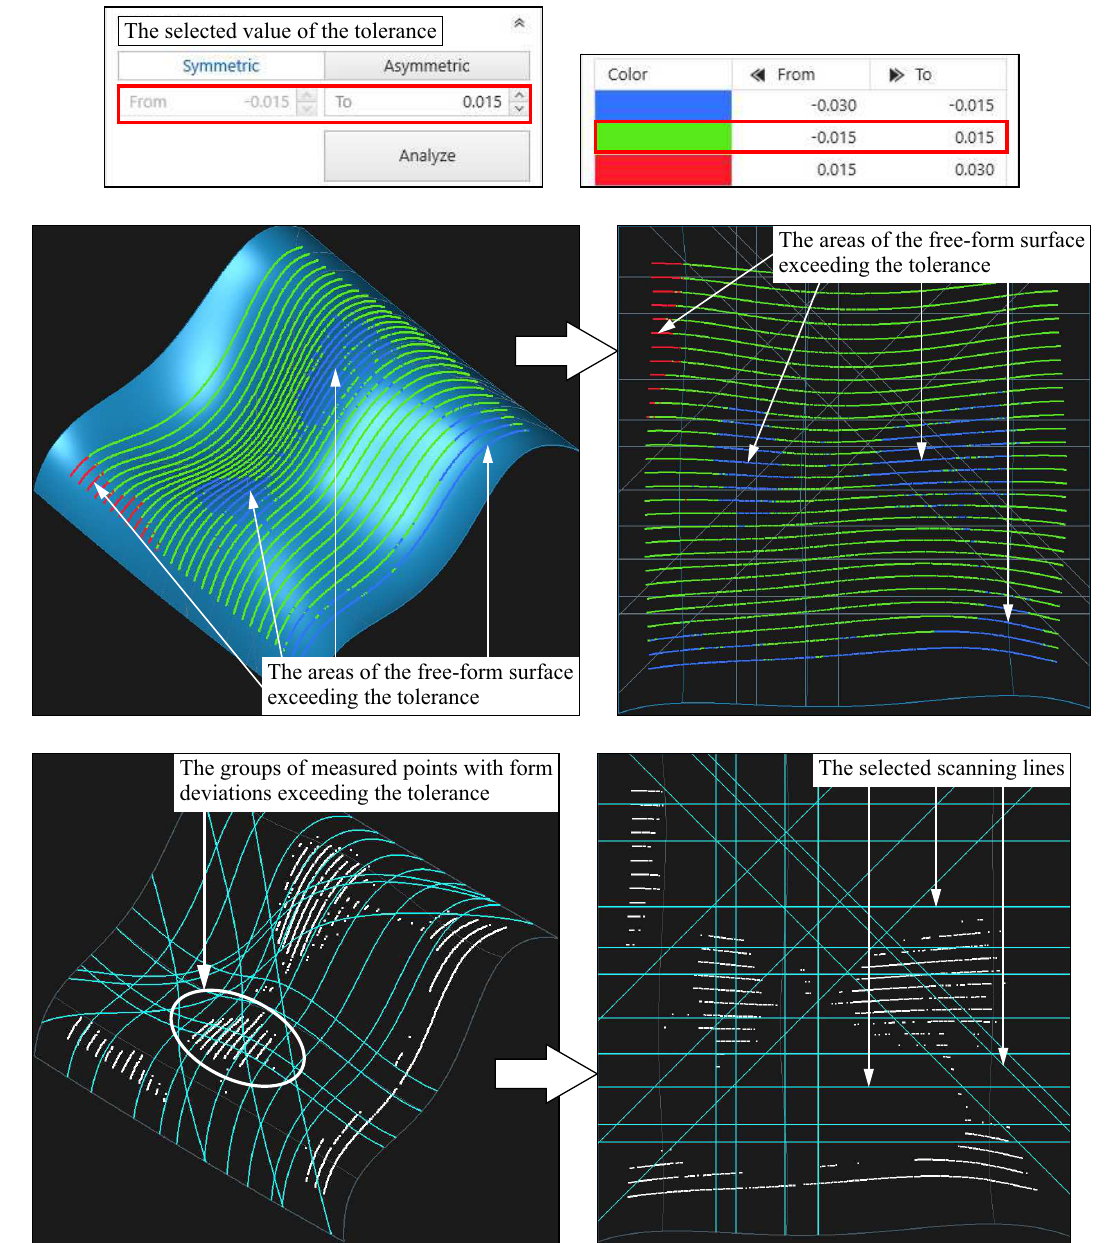
Figure 15. The distribution of form deviations on the measured free-form surface of the product together with the generated scanning lines and the selected value of the